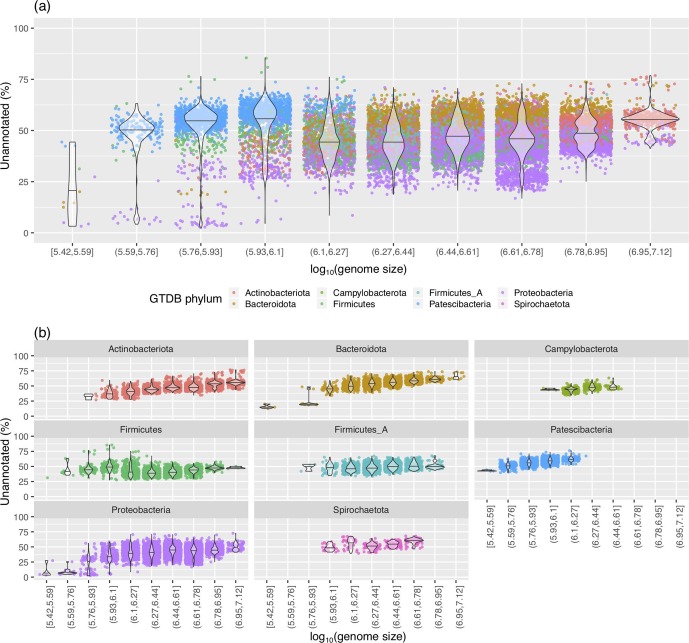
Effect of genome size (bp) on Prokka genome annotation coverage. The log10(genome size in bp) is binned into 10 distinct bins to better display the trend. Square and open brackets indicate intervals that include and do not include the adjacent number, respectively. (a) Only the most common GTDB phyla are shown. (b) The most common GTDB phyla are displayed separately.